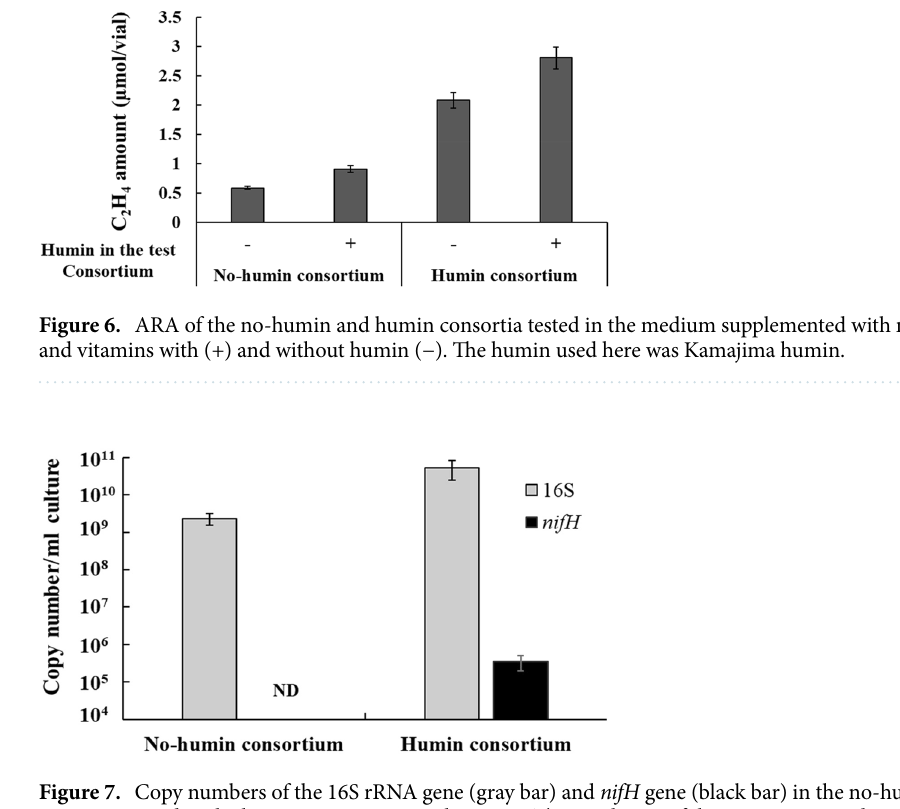
Figure 7. Copy numbers of the 16S rRNA gene (gray bar) and nifH gene (black bar) in the no-humin consortium and in the humin consortium in the qPCR. The amplicons of the genes were used to estimate the total and N-fixing population. The primer sets used are described in the materials and methods. ND not